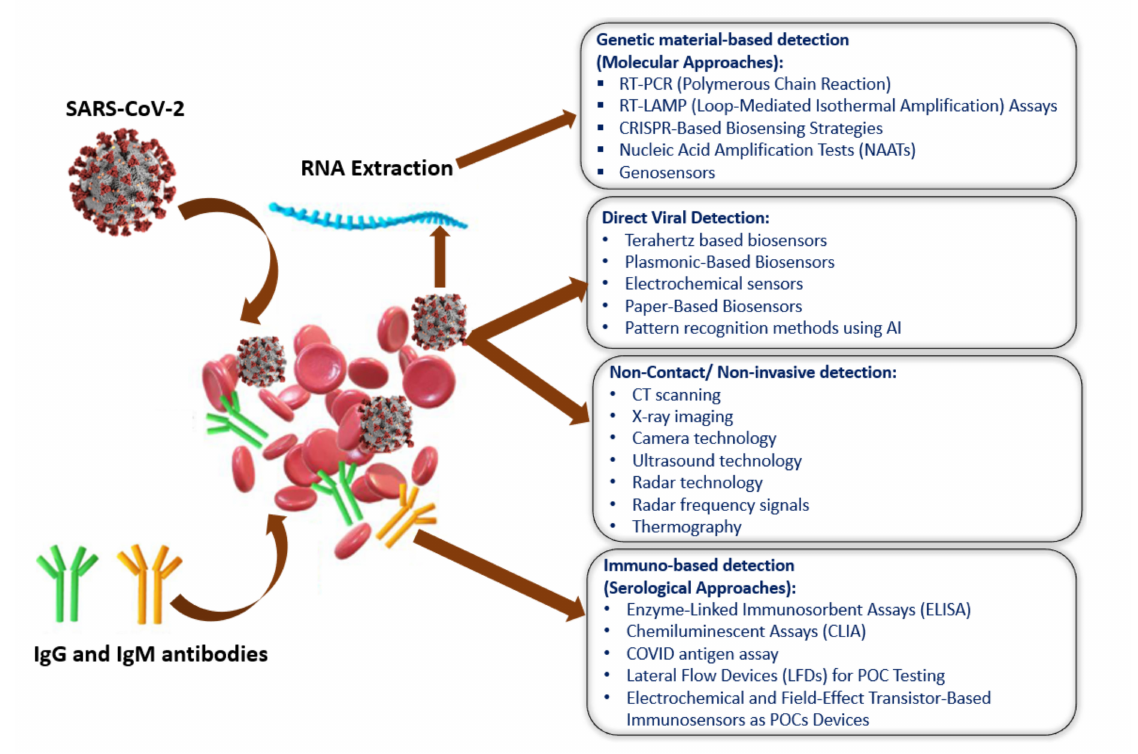
Figure 2. A visual summary of the currently available SARS-CoV-2 detection process. Reprinted with permission from [39]. Copyright 2020 American Chemical